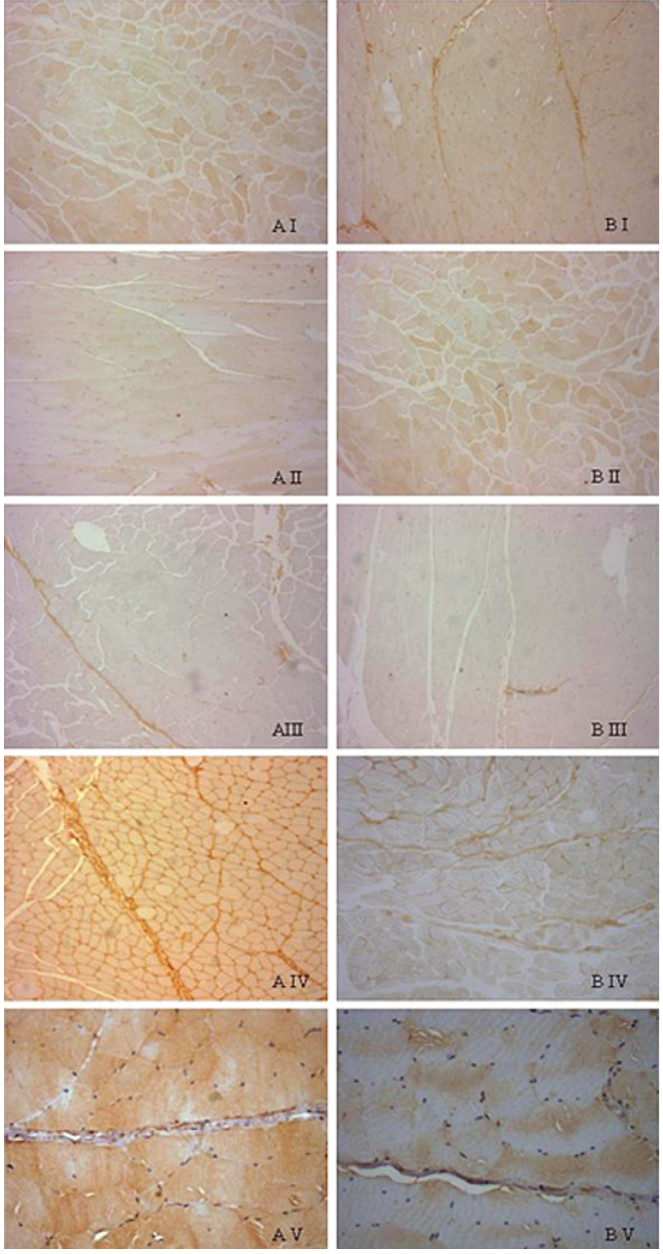
FIGURE 3 – Micrographs showing ( AI, BI ) type I collagen; ( AII, BII